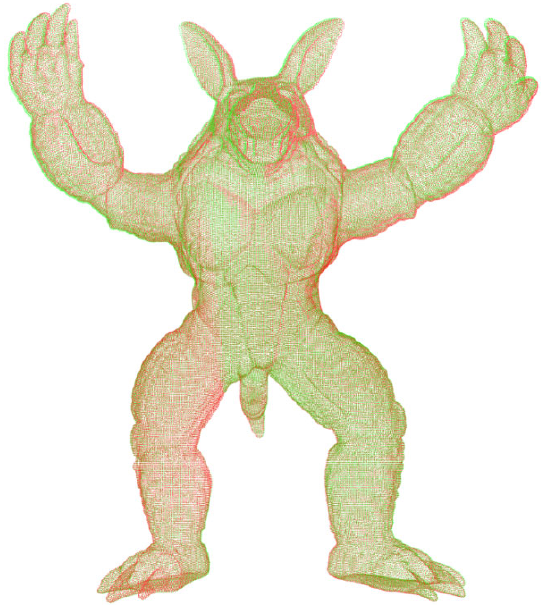
Figure 8. Point cloud register of armadillo. Table 2. Time performance of the proposed